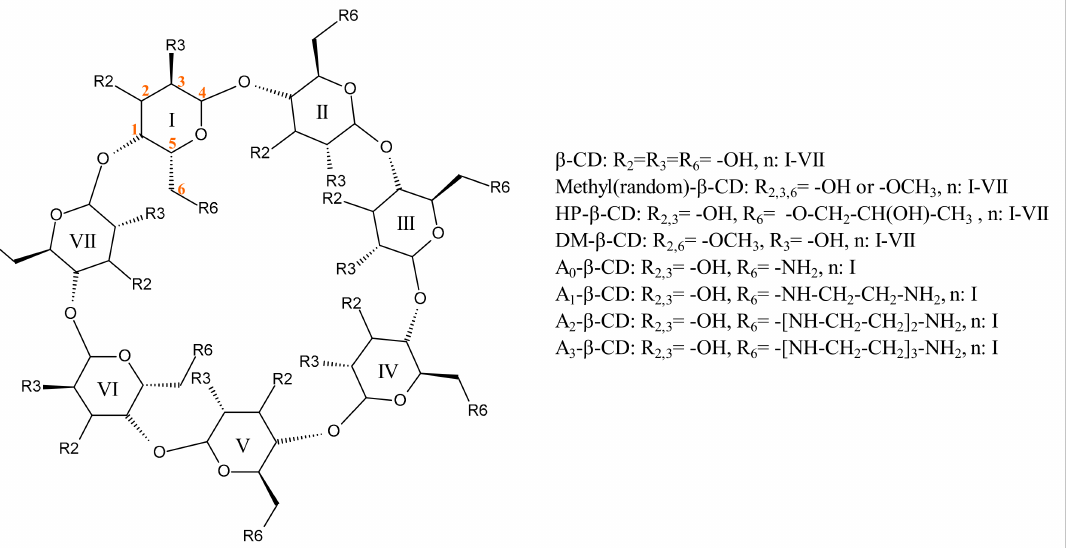
Figure 4. Chemical structure of β -CD derivatives: “n” denominates the glucopyranose ring/rings where the indicated functional groups are